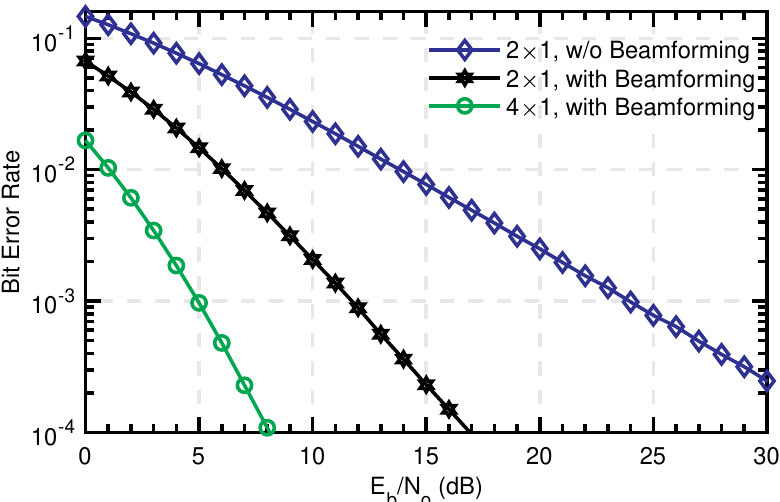
Figure 15. Multi–antenna schemes with and without transmit beamforming